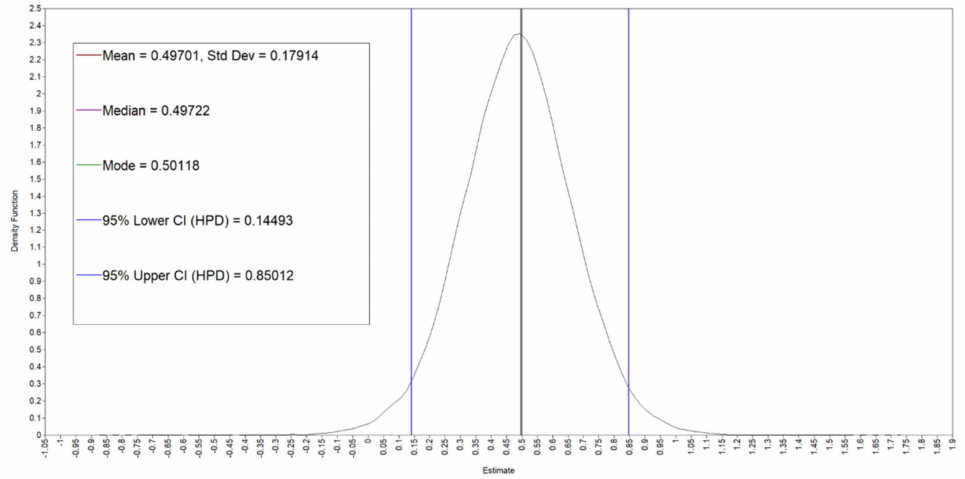
Figure 2. The kernel density plot for general emotional load on daily need satisfaction of